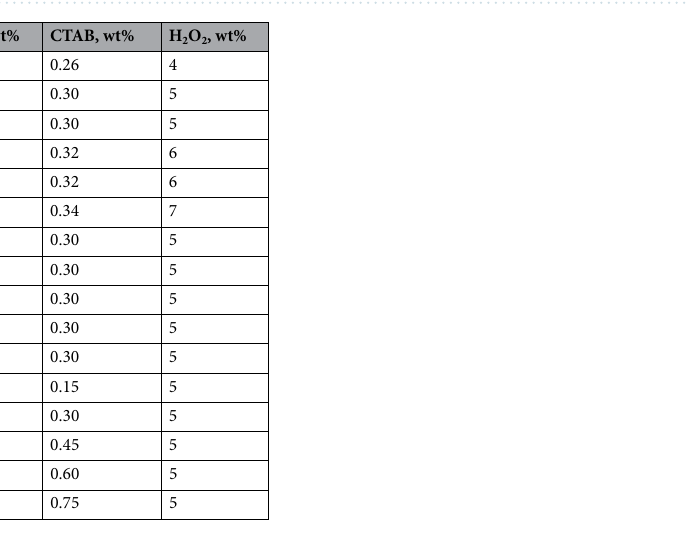
Figure 1. Analysis of smelting slag characteristics. ( a ) XRD pattern; ( b ) XRF analysis; ( c ) the particle sizes range.